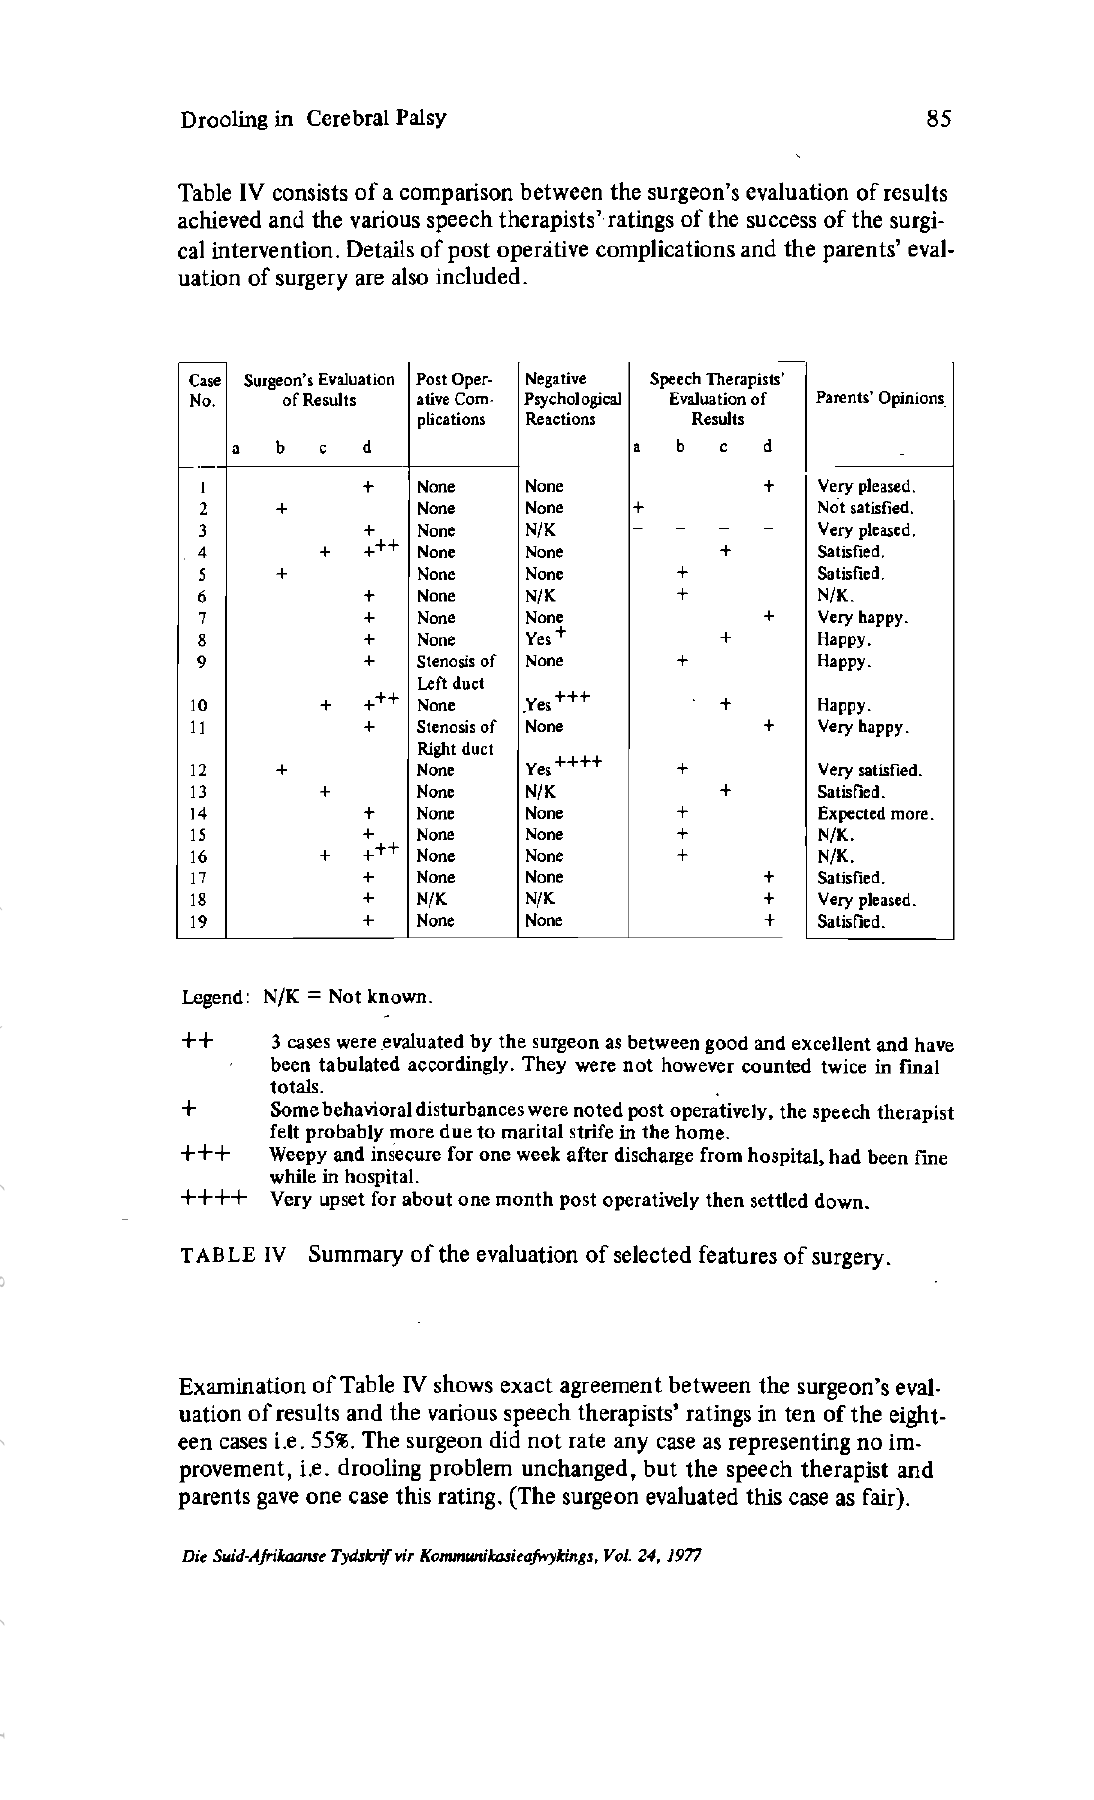
Examination of Table IV shows exact agreement between the surgeon's eval- uation of results and the various speech therapists' ratings in ten of the eight- een cases i.e. 55%. The surgeon did not rate any case as representing no im- provement, i.e. drooling problem unchanged, but the speech therapist and parents gave one case this rating. (The surgeon evaluated this case as